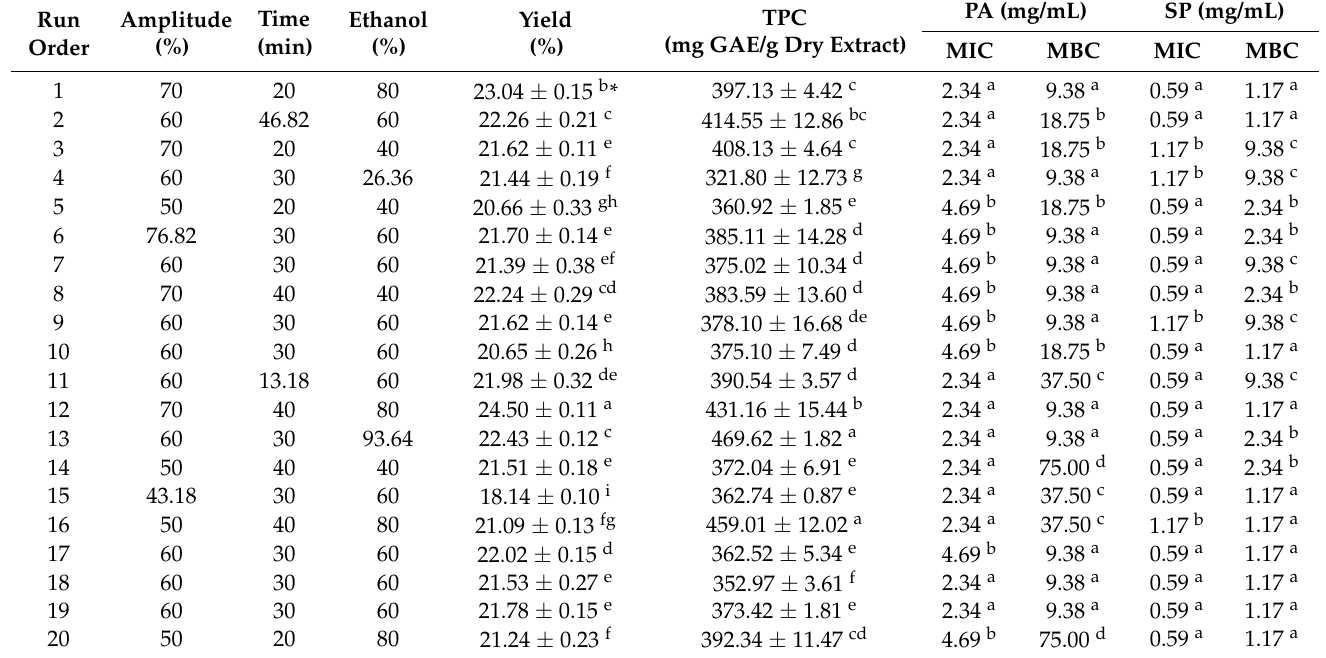
Table 2. Yield, total phenolic contents (TPC) and antimicrobial activities of CLE under different extracting conditions using central composite design